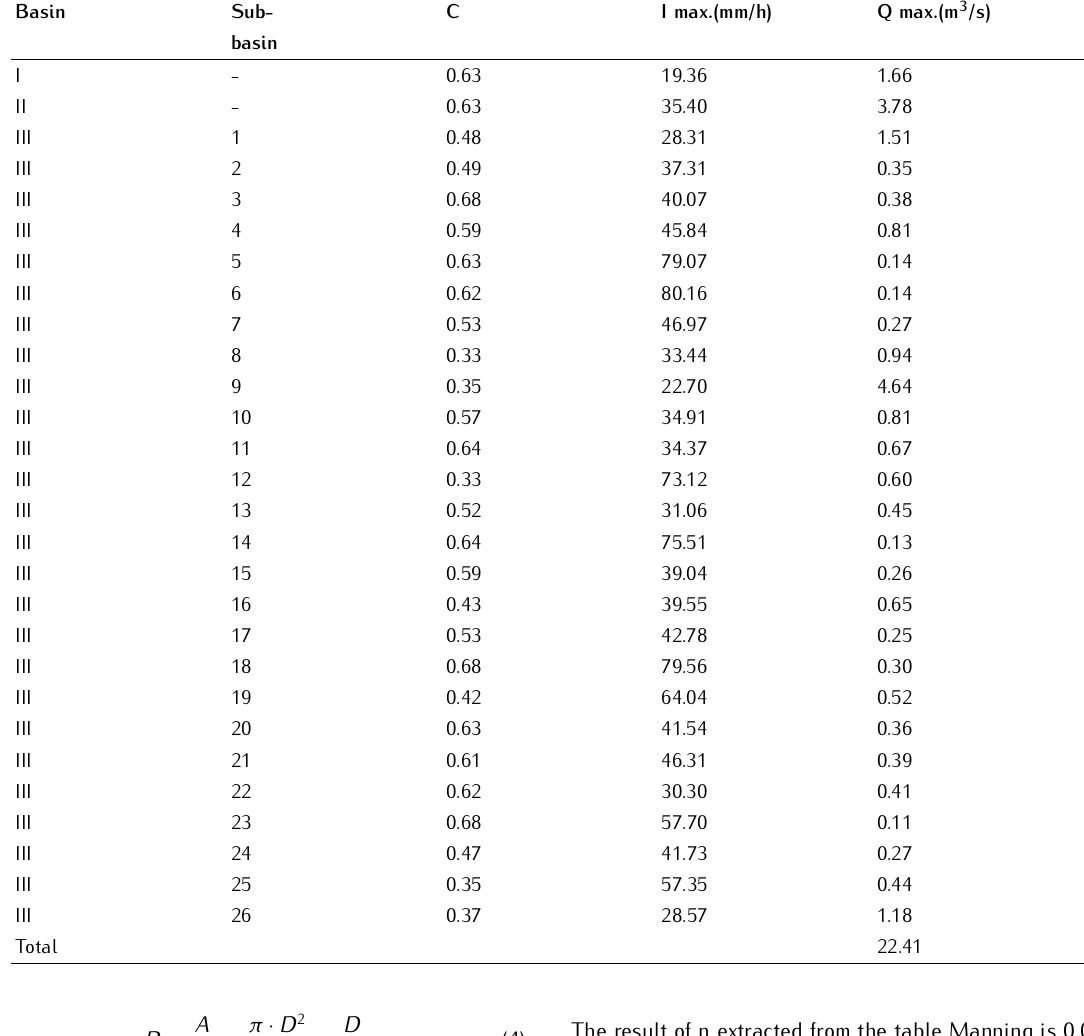
Table 3. Flow calculation for a return period of 5 years.